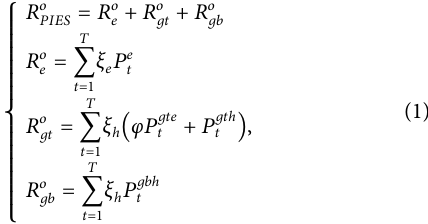
FIGURE 1 Internal structure diagram of